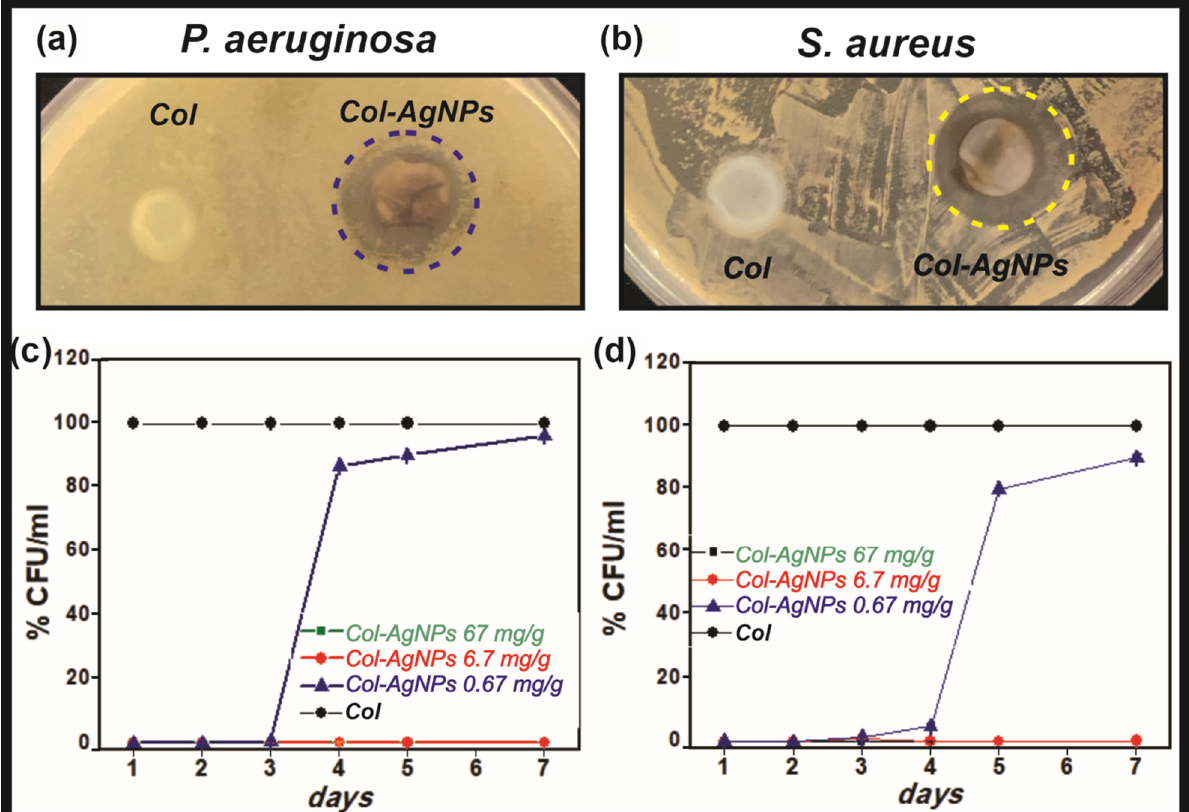
Figure 6 . Antimicrobial activity Col-AgNPs against S. aureus and P. aeruginosa . Collagen hydrogels containing AgNPs in contact with P. aeruginosa ( a ) and S. aureus ( b ). The % CFU/mL of each bacterium was studied during 7 days ( c , d ) for collagen control (Col, black), Col-AgNPs 67 mg/g (green), Col-AgNPs 6.7 mg/g (red) and Col-AgNPs 0.67 mg/g (blue). Results are expressed as mean ± SD from triplicate experiments.